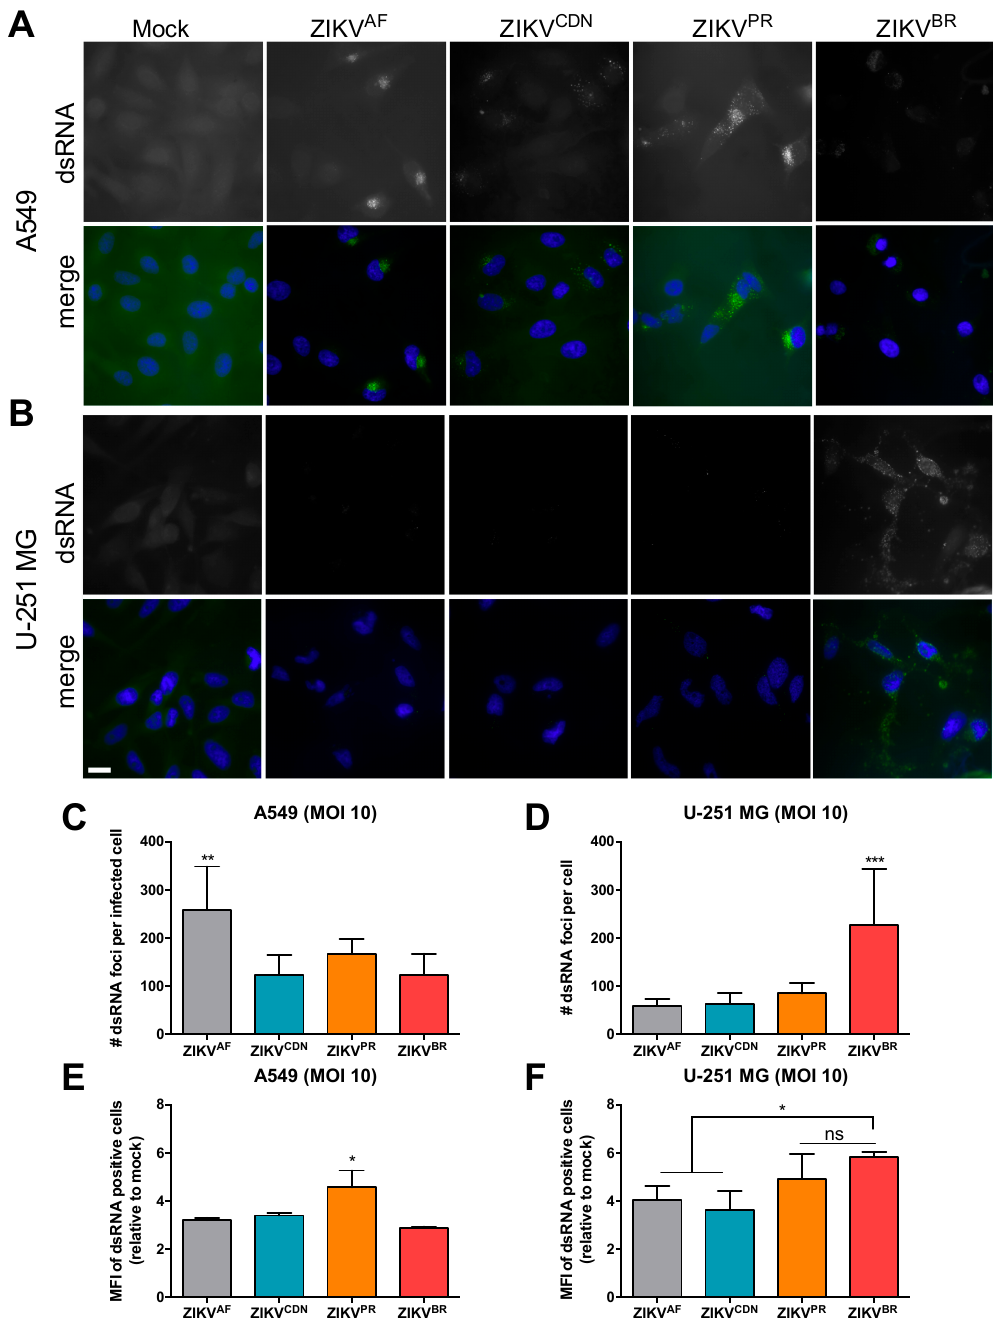
Figure 4. Isolate-specific differences are observed in number and fluorescence intensity of dsRNA foci in infected cell. ( A ) A549 and ( B ) U-251 MG cells were infected with ZIKV at MOI = 10 and 24 h post-infection dsRNA expression was analyzed by immunofluorescence microscopy. Scale bar, 20 µ m. The number of dsRNA foci per cell in ( C ) A549 and ( D ) U-251 MG cells was quantified using Imaris software (>100 cells/condition). ( E ) A549 and ( F ) U-251 MG cells were infected with ZIKV at MOI = 10 and 24 h post-infection the mean fluorescence intensity (MFI) of dsRNA-positive cells was determined by flow cytometry. Values represent mean ± SEM of at least three independent experiments. Asterisks indicate significant differences: * p < 0.05, ** p < 0.01, *** p < 0.001.